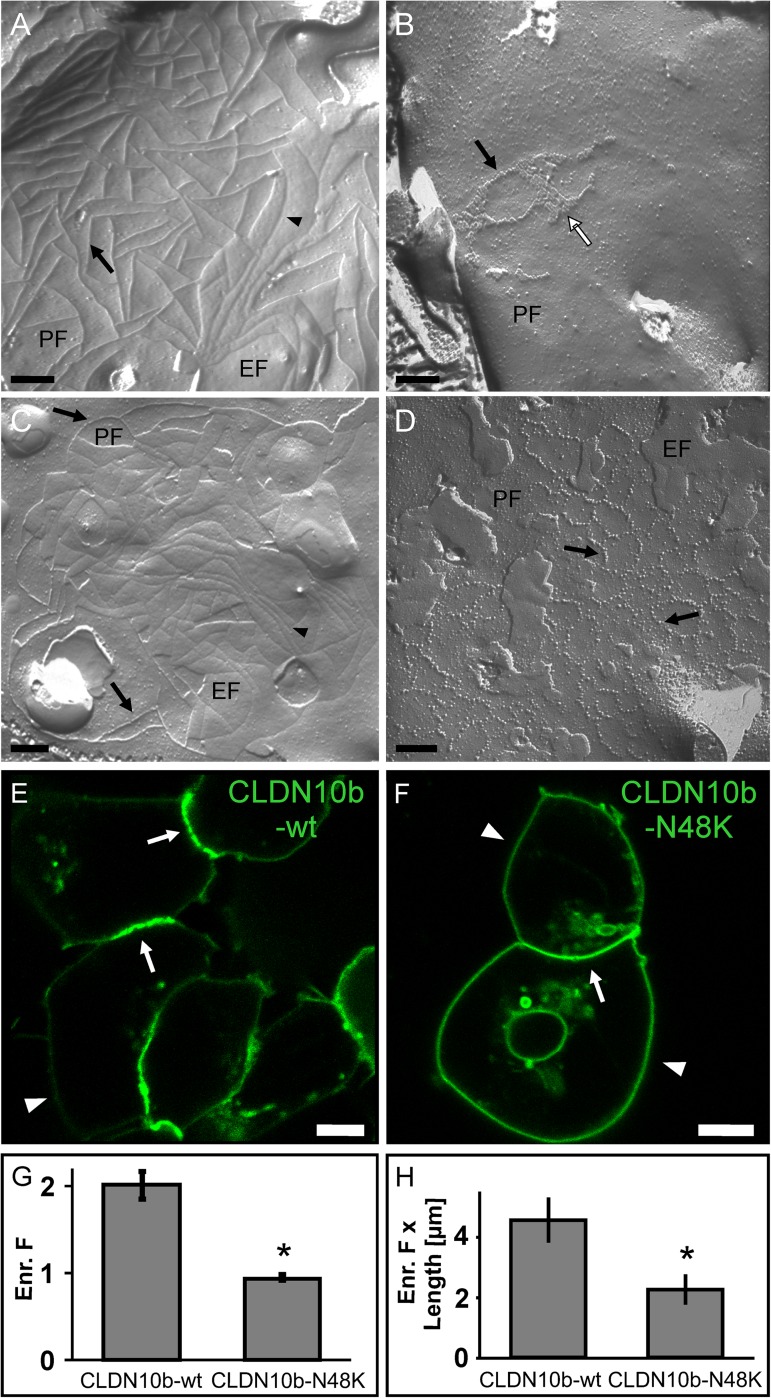
Perturbed formation of tight junctions and inhibition of claudin-10b trans-interactions by the N48K mutation.(A-D) Freeze fracture electron microscopy of HEK293 cells expressing YFP-claudin-10b. (A) Stable expression of wt claudin-10b led to formation of complex mesh-works of branched tight junction strands. Numerous continuous strands (arrow) were detected on the protoplasmic face (P-face, PF) and as particle-free grooves (arrowhead) on the exoplasmic face (E-face, EF) of the plasma membrane. (B) Stable expression of claudin-10b N48K resulted in few tight junction strands and less complex meshworks. Strands were detected on the P-face as rows of rather separated intramembranous particles (black arrow) and two- dimensional particle arrays (white arrow). (C) Similar to the stable expression, transient expression of wt claudin-10b led to mesh-works of continuous tight junction strands detected on the P-face (arrow) and E-face (arrowhead). (D) For transient expression of claudin-10b N48K, tight junction mesh-works were infrequent. Particle-type strands were detected as noncontinuous rows of separated, beaded intramembranous particles (black arrow) on the P-face. Scale bars, 200 nm. (E-H) Inhibition of YFP-claudin-10b trans-interactions by the p.N48K mutation. (E) Transiently expressed claudin-10b WT (green) is enriched at contacts (arrows) between claudin-expressing HEK293 cells suggesting trans-interaction. Arrowheads indicate plasma membrane outside of contacts between two claudin-expressing cells. (F) Transient expression of claudin-10b N48K (green) in HEK293 cells does not show strong enrichment at contacts (arrows) between cells suggesting lack of trans-interaction. (G) For transient expression in HEK293 cells, the enrichment factor (Enr. F) was significantly lower for claudin-10b N48K compared to claudin-10b WT. n = 27–44; *, p < 0.01. (H) For stable expression in HEK293 cells, the product of enrichment factor and length of enrichment (Enr. F x Length) was significantly lower for claudin-10b N48K compared to claudin-10b WT. n = 27–42; *, p < 0.01. Means +/- SEM. Size bars: 5μm.